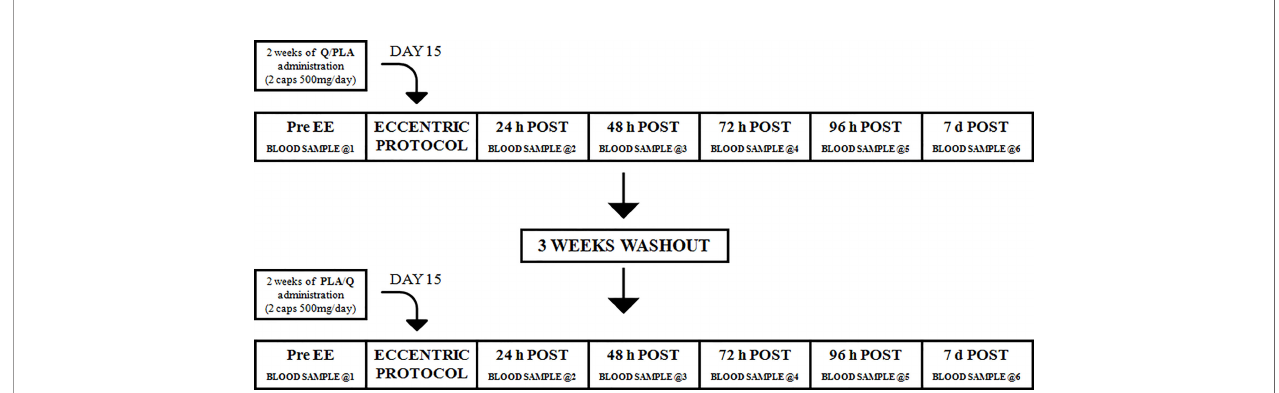
FIGURE 1 | Flow diagram of the study. Twelve subjects were randomly assigned to quercetin group (n = 6) or to placebo group (n = 6) and then crossed over to the opposite condition. Subjects were given two caps of quercetin (1 g/d) or placebo for 2 weeks. On day 15, subjects were submitted to eccentric exercise (EE). Blood collections were performed before the EE (Pre EE), 24, 48, 72 and 96 hours (24 h – 96 h), and 7 days after EE (7